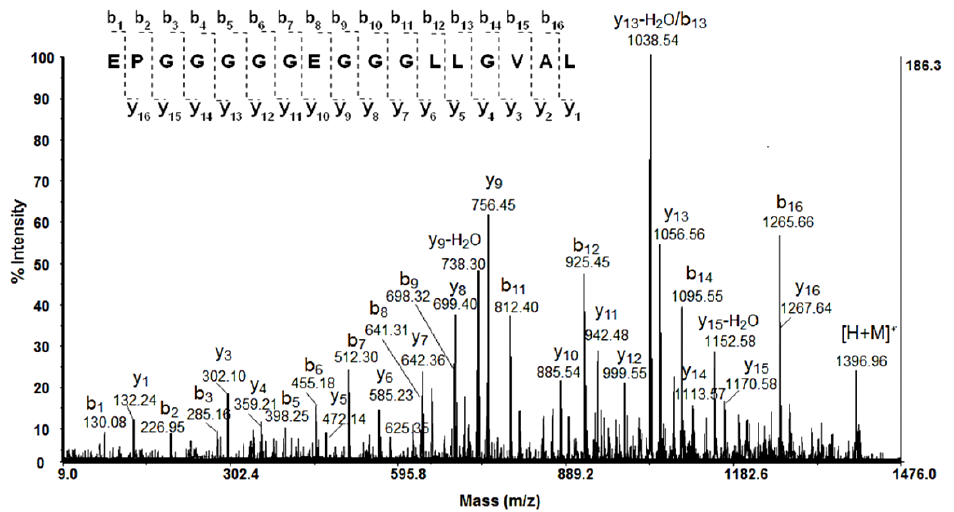
Figure 4. MALDI-MS/MS spectrum of peptide [M + H] + at m/z 1396.96 Da. The sequence EPGGGGGEGGGLLGVAL was determined by de novo sequencing.